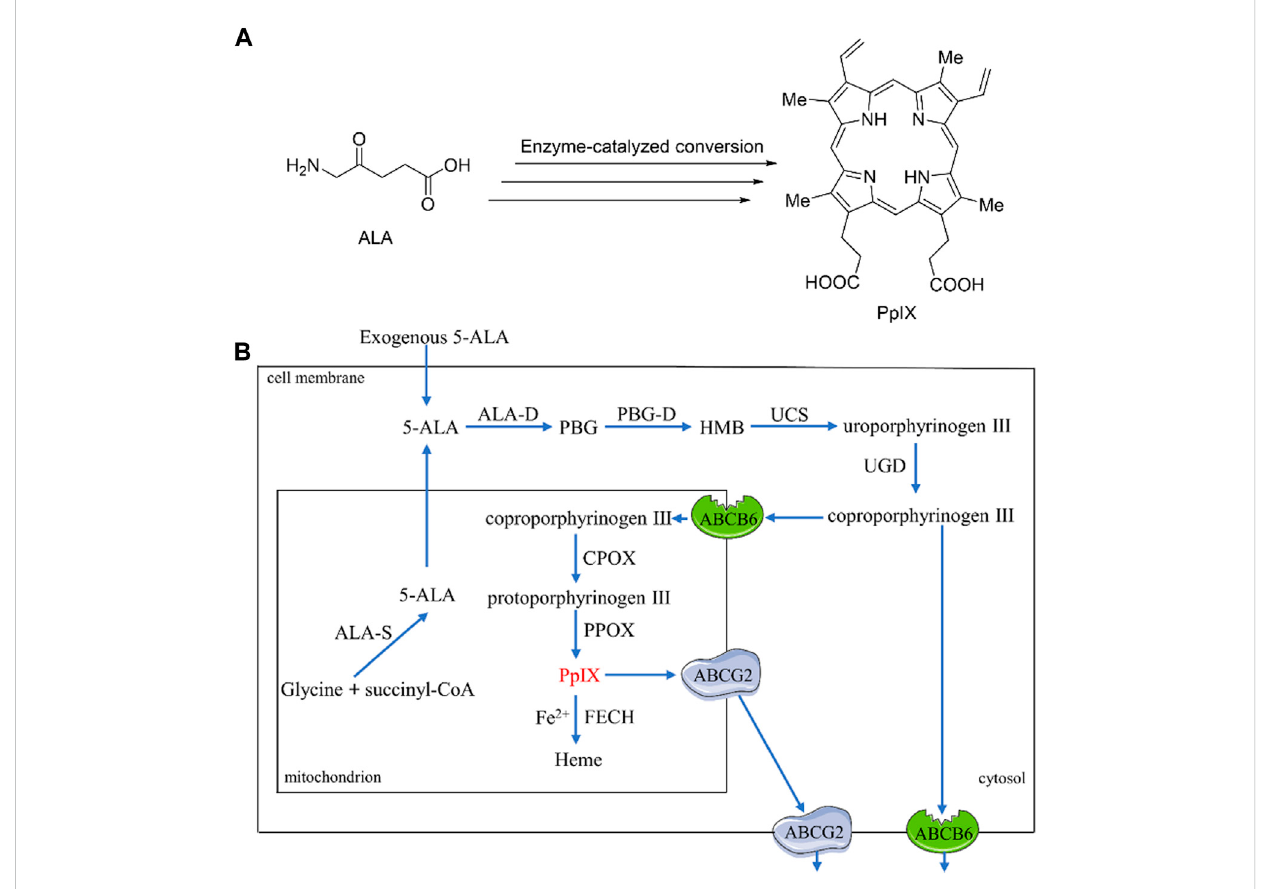
FIGURE 1 (A) Structures of ALA and PpIX; (B) A simpli fi ed mechanism of enzyme-catalyzed bio-transformation from ALA to